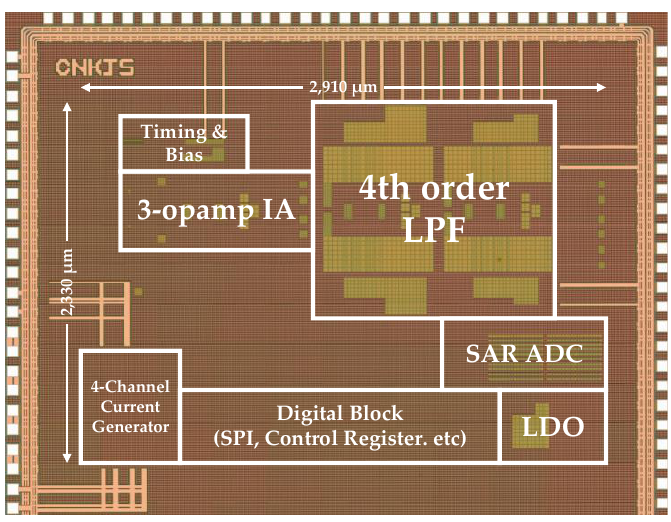
Figure 10. Die photograph of fabricated four-channel low-noise readout IC.